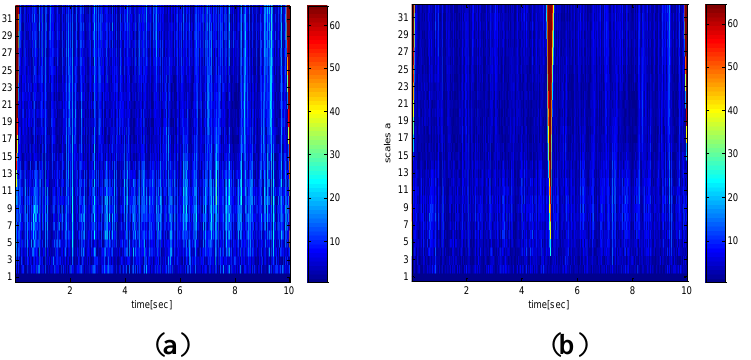
Figure 6. Sensor signal analysis result using the wavelet transform. ( a ) fault-free case. ( b ) fault case.